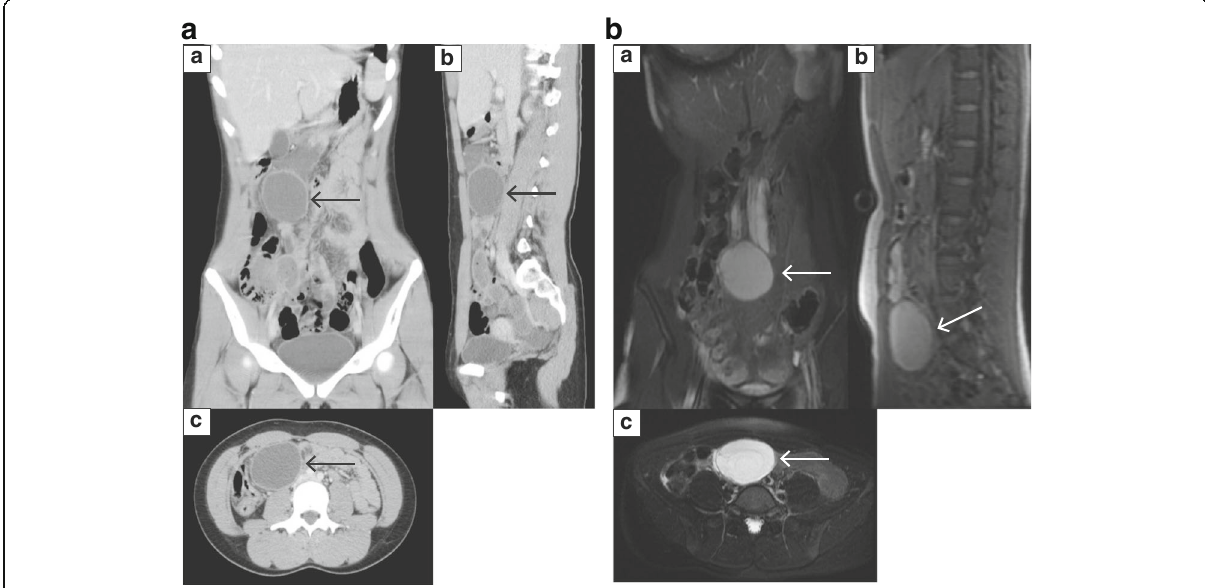
Fig. 1 Imaging studies. a Computed tomography of the abdomen. Coronal (a), sagittal (b), and axial (c) images show a well-defined, rounded mass measuring 10 cm along the greatest dimension (arrows). b T2-weighted fast spin echo magnetic resonance image of the abdomen. Coronal (a), sagittal (b), and axial (c) images show a well-defined, rounded mass measuring 10 cm along the greatest dimension (arrows), indicative of a mesenteric